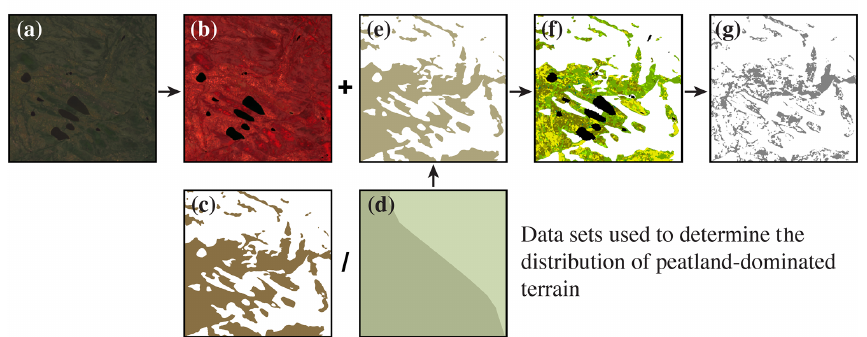
Figure 2. A summary of the regional geomatics methods used over a 2km × 2km sample area. There are two main workflows highlighted, i.e. the data sets used to map probable peatland-dominated terrain and the methods used to determine fractional forested area within those peatland-dominated areas. (a) Multispectral Landsat 8 imagery. (b) False colour infrared Landsat 8 imagery. (c) Natural Resources Canada saturated soils data set. (d) Northern Circumpolar Soil Carbon Database (NCSCD) fractional area of organic soils. (e) Probable peatland- dominated terrain. (f) Unsupervised classification identifying land covers within peatland-dominated terrain. (g) Coniferous forest cover within peatland-dominated